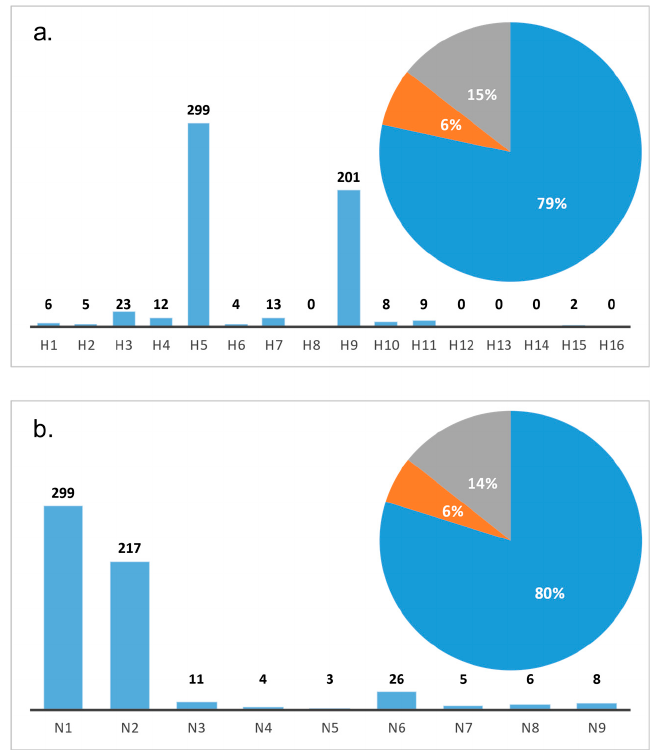
Figure 2. Occurrence of avian influenza virus subtypes in Bangladesh based on hemagglutinin ( HA ) ( a ) and neuraminidase ( NA ) ( b ) sequences available in public databases and distribution of host species origin (blue—poultry (79 and 80%), orange—wild birds (6% each), and grey—environment (15 and 14%)).